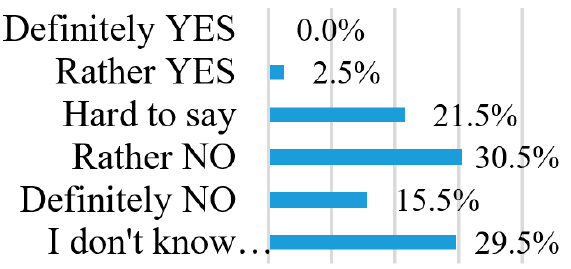
Figure 4. Opportunities for raising capital for development through the stock exchange. Source: Own